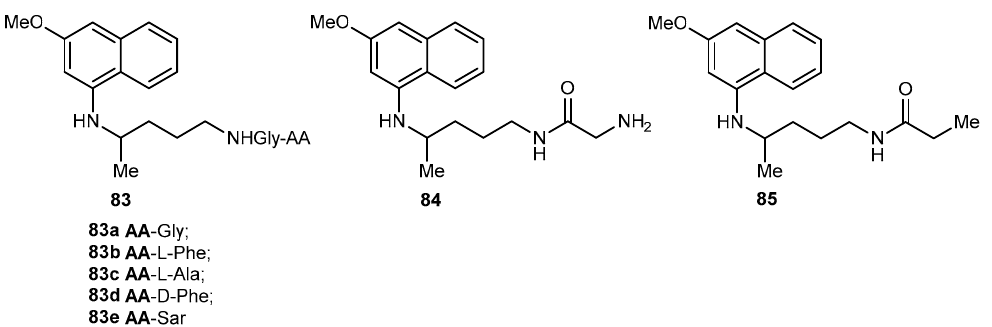
Figure 35. Dipeptides derivatives of 6 synthesized by Portela et al. [37].